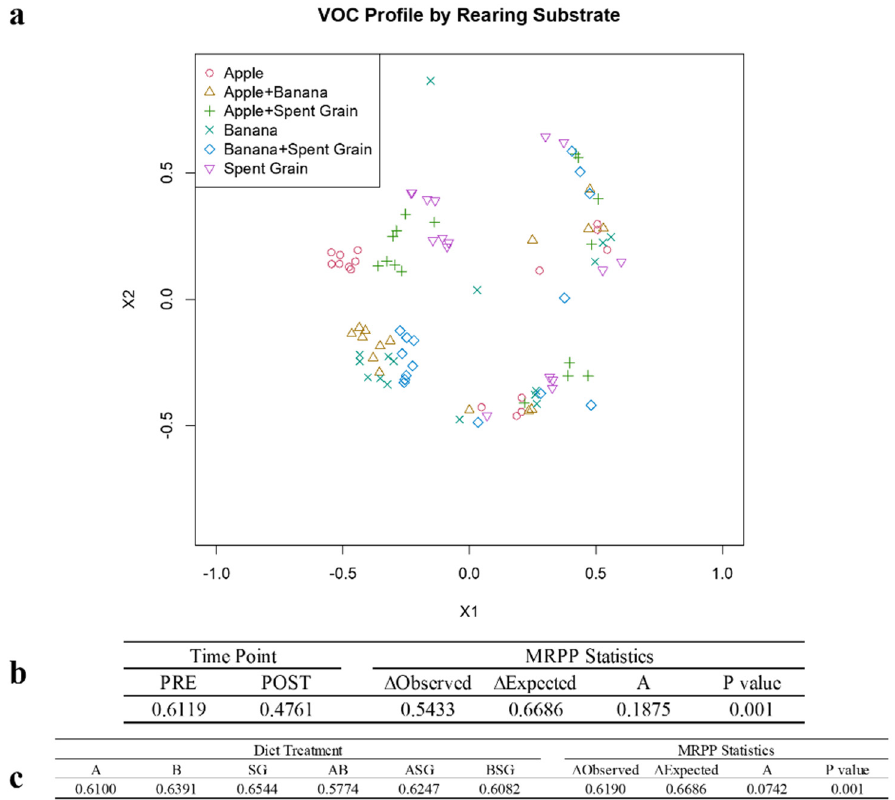
Figure 2. Identification of VOCs: ( a ) Nonmetric multidimensional scaling (NMDS) ordination of the overall VOC profiles for all six diet treatments, before and after feeding by BSF larvae. The vertical black line on the graph represents the separation in VOC profiles between the two sampling time points; ( b ) Bray–Curtis dissimilarity values ( ∆ ) and MRPP statistics for the overall VOC profile for each sampling time point: PRE (before) and POST (after) feeding by BSF larvae, for all six diet treat- ments combined; ( c ) Bray–Curtis dissimilarity values ( ∆ ) and MRPP statistics for each diet treat- ment. A, apple; B, banana; SG, spent grain; AB, apple and banana; ASG, apple and spent grain; BSG, banana and spent grain.